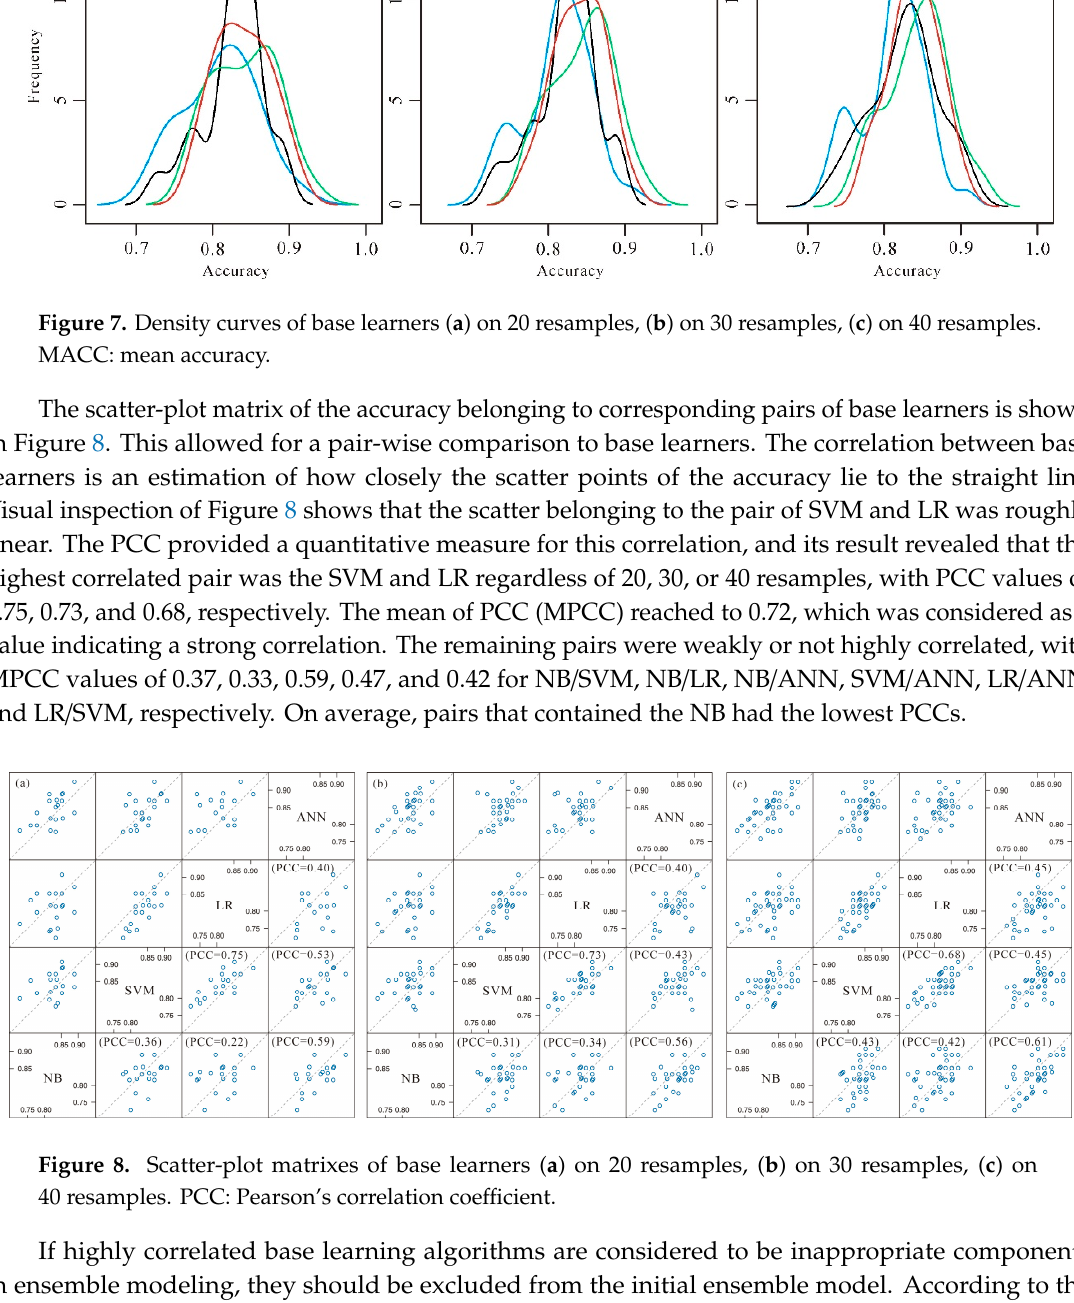
Figure 8. Scatter-plot matrixes of base learners ( a ) on 20 resamples, ( b ) on 30 resamples, ( c ) on 40 resamples. PCC: Pearson’s correlation coefficient.